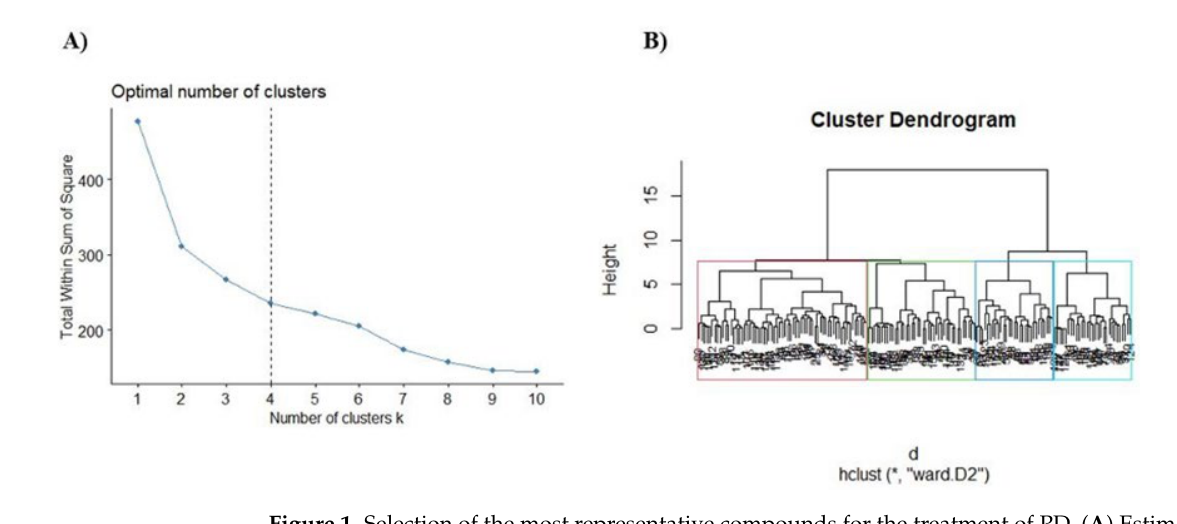
Figure 1. Selection of the most representative compounds for the treatment of PD. ( A ) Estimation of the optimal number of clusters. ( B ) Dendrogram − hierarchical clustering (hclust) of the compounds for PD treatment using Ward’s method (*, ward D2).